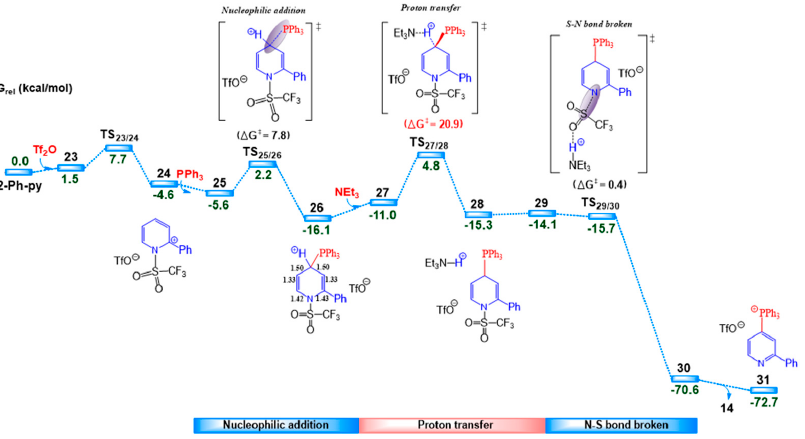
Figure 6. Free energy profile of pyridine phosphination with PPh 3 .